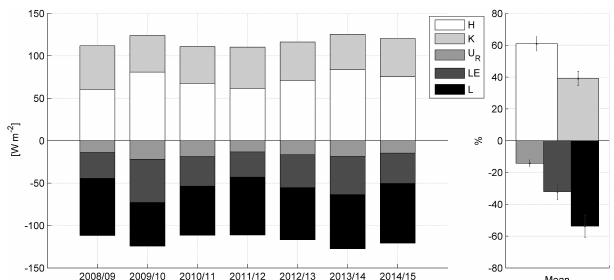
Figure 10. Annual mean energy balance (Wm − 2 ) over the snow- pack at the Refugio Poqueira site from the hydrological year 2008/2009 to 2014/2015 and average proportions of the fluxes, warming as positive (exchange of sensible heat, H , and shortwave radiation, K ) and cooling as negative (heat advected to precipita- tion, U R , exchange of latent heat, LE, and longwave radiation, L